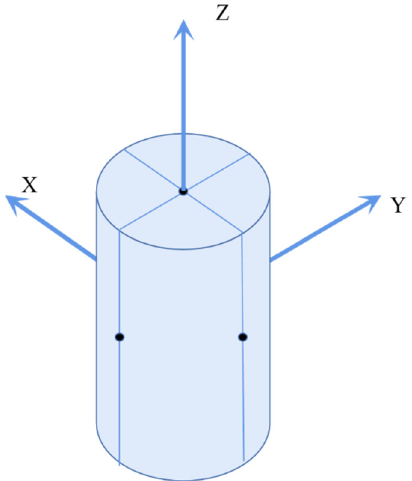
Figure 3. Distribution of measurement.